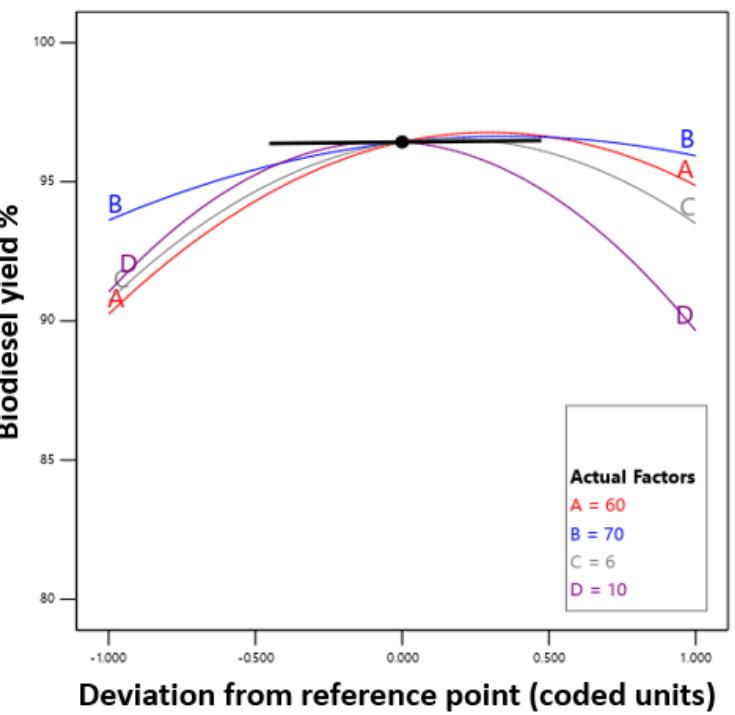
Figure 11. Perturbation plot exhibiting significant variables affecting biodiesel yield%.